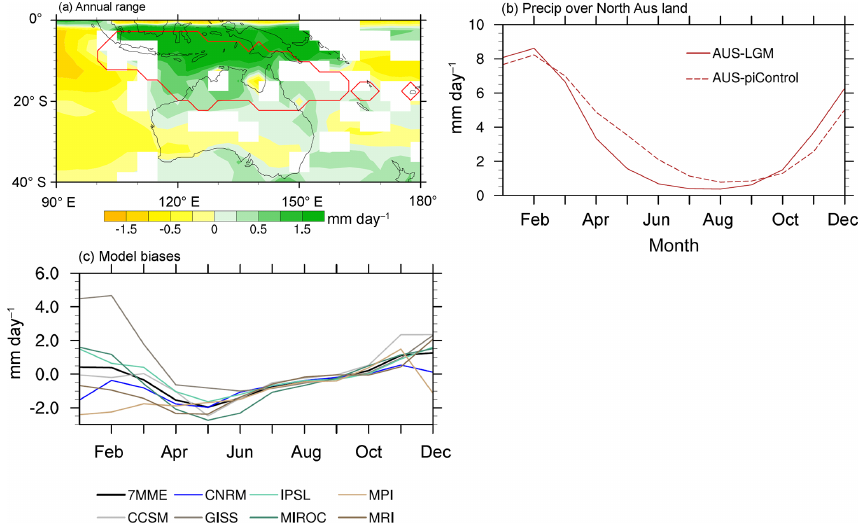
Figure 1. (a) Spatial distribution of changes in the annual range (AR) of precipitation measured by the difference between LGME and piControl, (b) seasonal distribution of the precipitation in the increased AR area (20–5 ◦ S, 120–145 ◦ E), and (c) seasonal distribution of the precipitation differences in the increased AR area derived from the 7MME (black line) and each model (colored lines). The solid red line in (a) encloses the Australian monsoon rainfall domain. The dashed (solid) line in (b) denotes the seasonal distribution of precipitation derived from the piControl (LGME) run. Only those areas where the signal-to-noise ratio exceeds 1 are plotted in (a) .